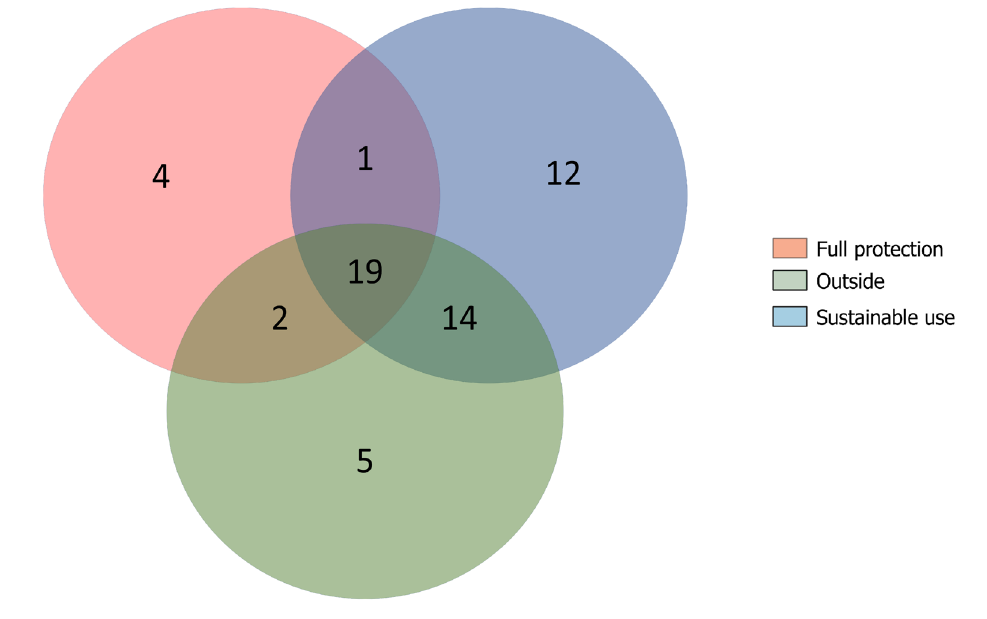
FIGURE 2 | Species richness shared and exclusive of the stream stretches from full protection, sustainable use, and outside areas.